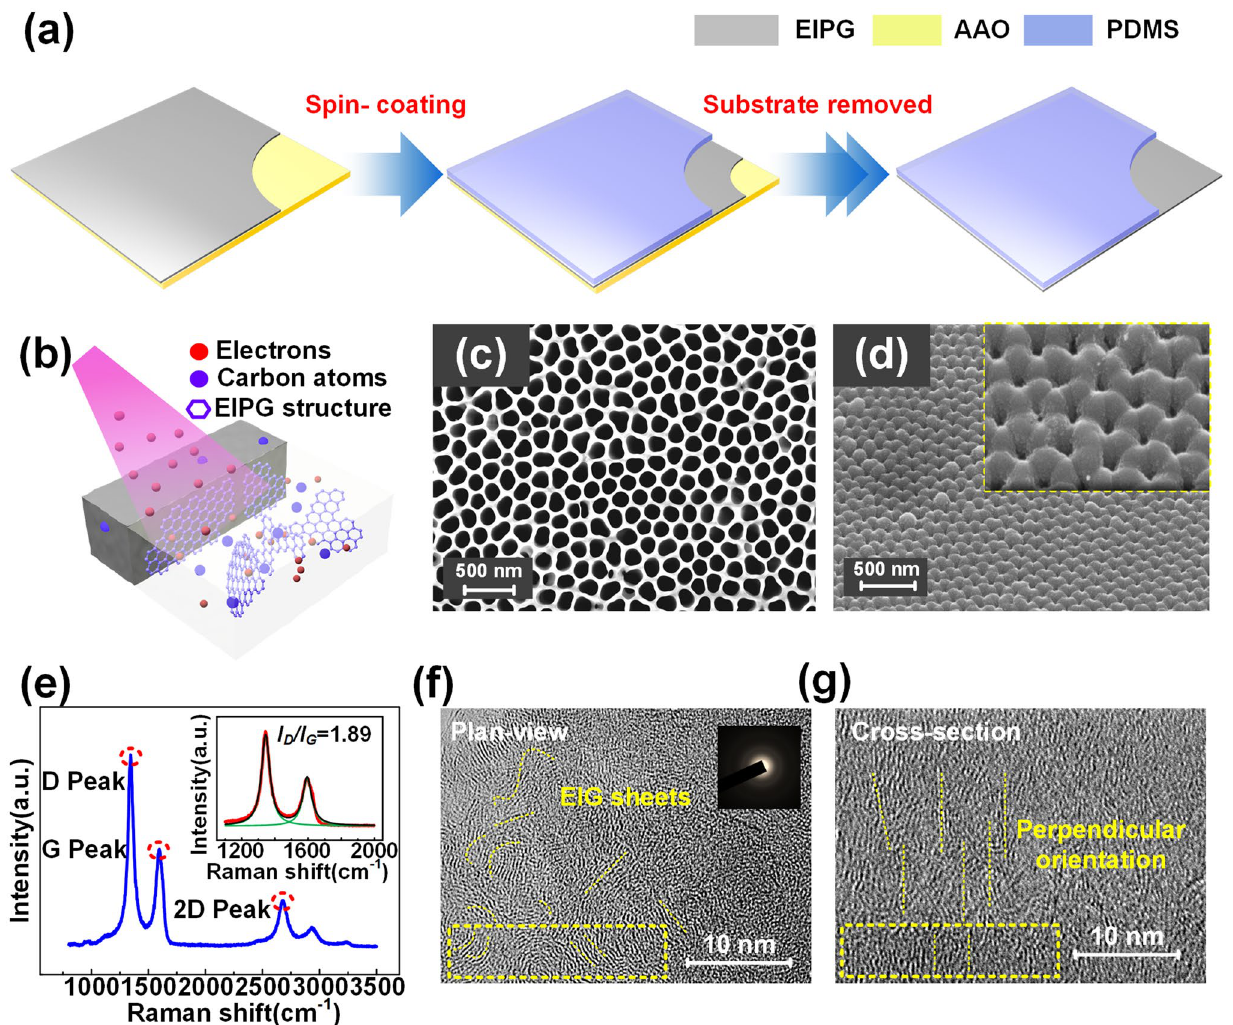
Fig. 1 a Schematic illustration for the flexible EIPG electrode using spin coating and lift‑off methodology. b Synthesizes process of perpendicu‑ lar orientation of graphene sheets. c Field‑emission scanning electron micrographs of AAO substrate and d deposited porous EIPG carbon film. e Raman spectrum of deposited EIPG electrode. f The HRTEM image of the plan‑view of the EIPG electrode and g cross section of the EIPG